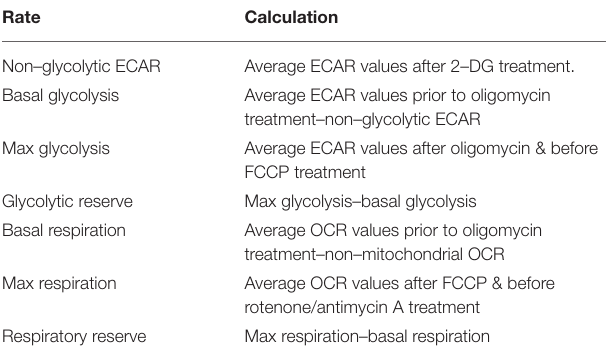
TABLE 1 | Seahorse